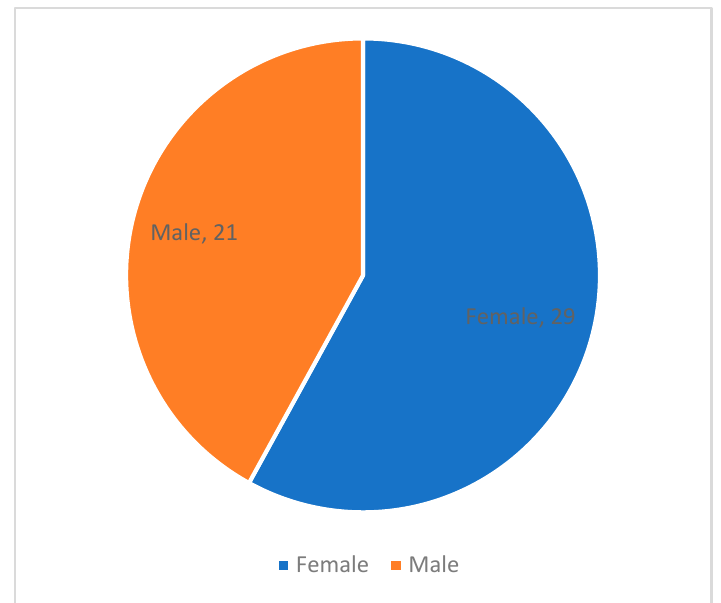
Figure 1. Gender distribution of the included patients.